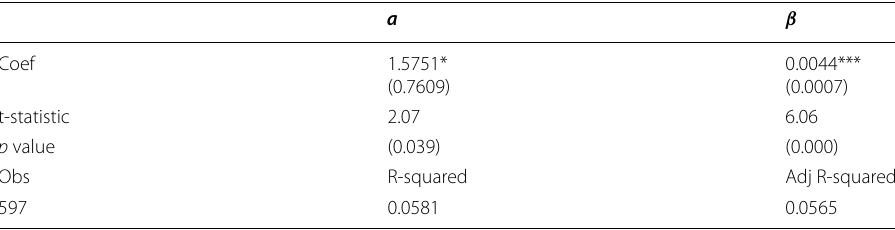
Table 1 Estimation results of � M t = a + β ∗ M t − 1 + u t